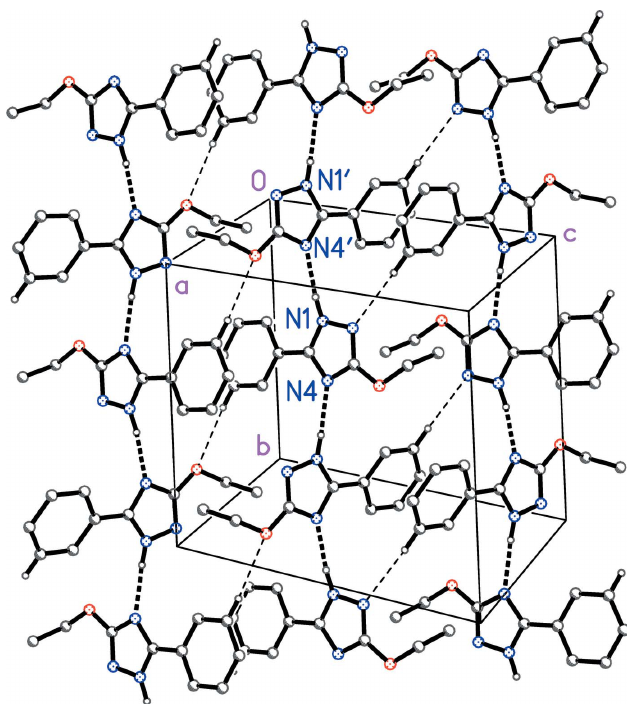
Figure 4 Packing diagram of compound ( 7 ), viewed perpendicular to plane (101). Classical hydrogen bonds are indicated by thick dashed lines, C—H (cid:3)(cid:3)(cid:3) X interactions by thin dashed lines (see Table 1). Hydrogen atoms not involved in hydrogen bonding have been omitted for